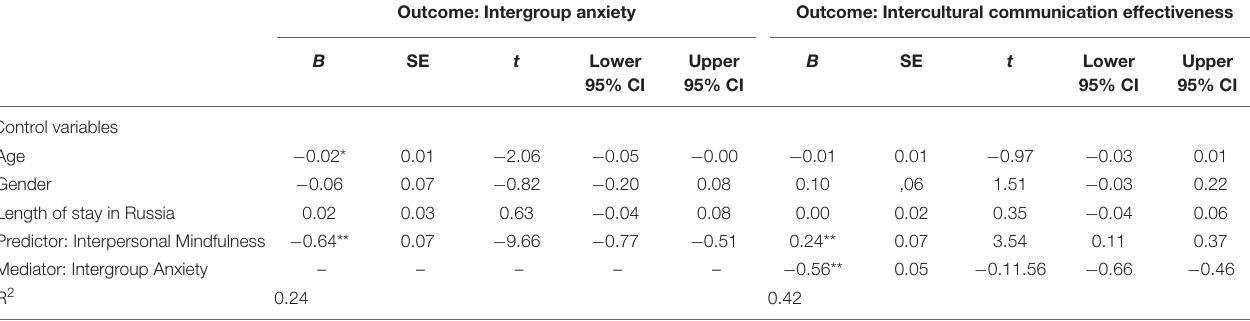
TABLE 2 | Path coefficients for relation proposed in hypotheses. Outcome: Intergroup anxiety Outcome: Intercultural communication